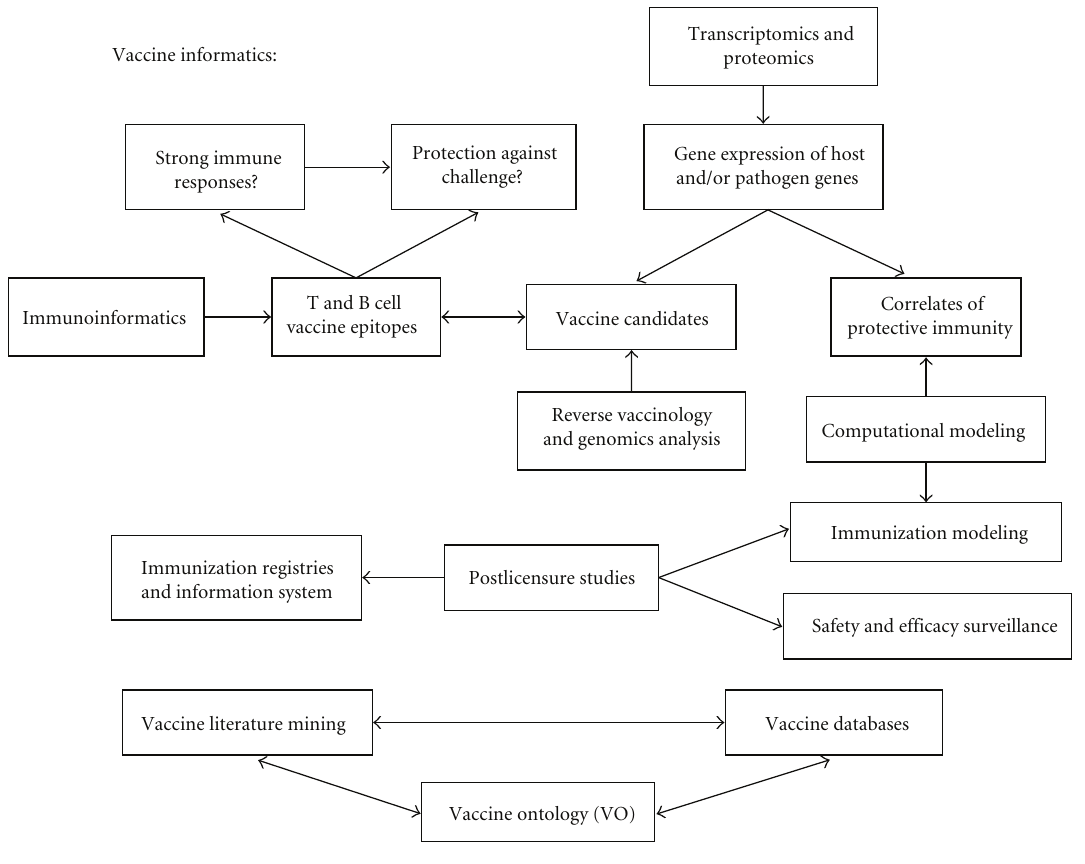
Figure 1: Overview of current vaccine informatics